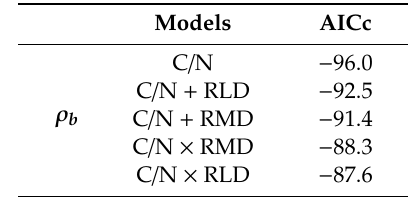
Table 5. Selected models tested for bulk density predictors arranged from the smallest Akaike’s Information Criterion (AICc) to the